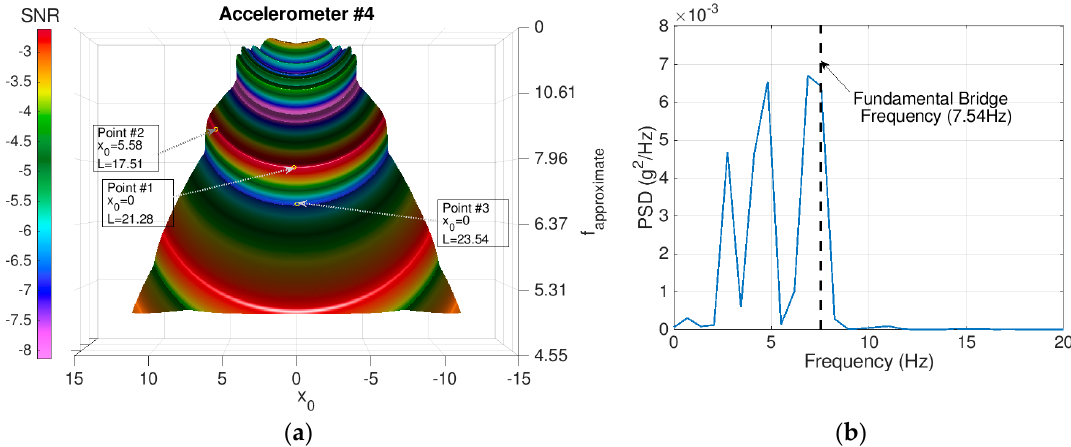
Figure 20. The example illustrates the effect of poor selection of potential parameters on PSD for the extracted signal. ( a ) FI-UPSR surface plot for Test #3 and ( b ) PSD plot for extracted signal using the potential parameters for Point #3.